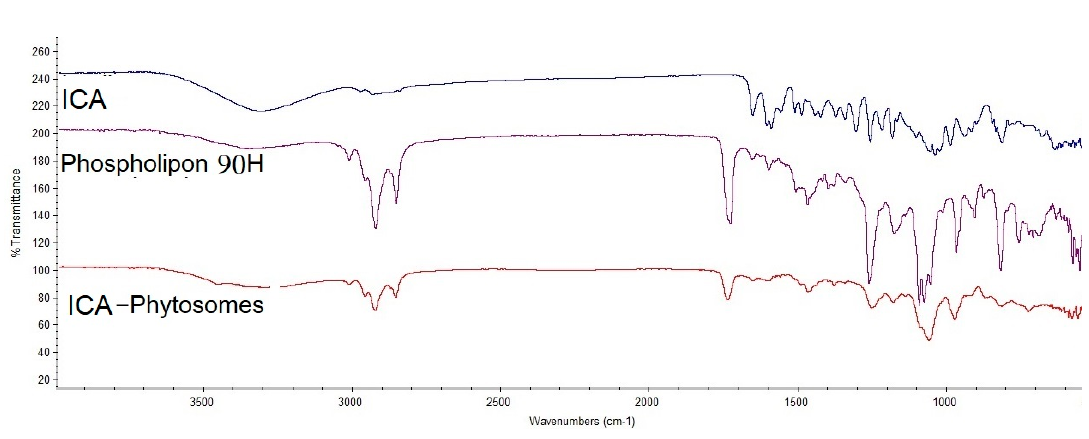
Figure 5. Fourier-transform infrared (FTIR) of ICA, Phospholipon ® 90H, and ICA-phytosomes.